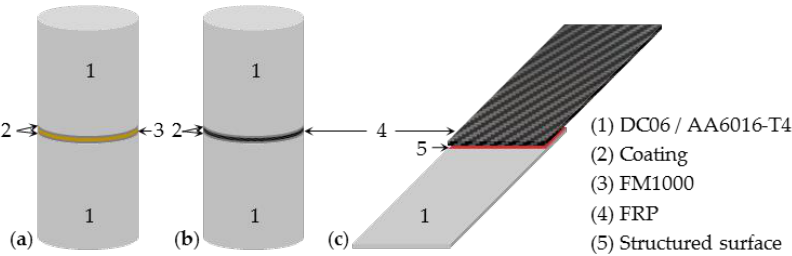
Figure 3. Setup for evaluating ( a ) the axial bonding strength of the thermal spray coating to the metal sheet; ( b ) between the coating and the FRP; and ( c ) the tensile shear strength of different surface structures to the